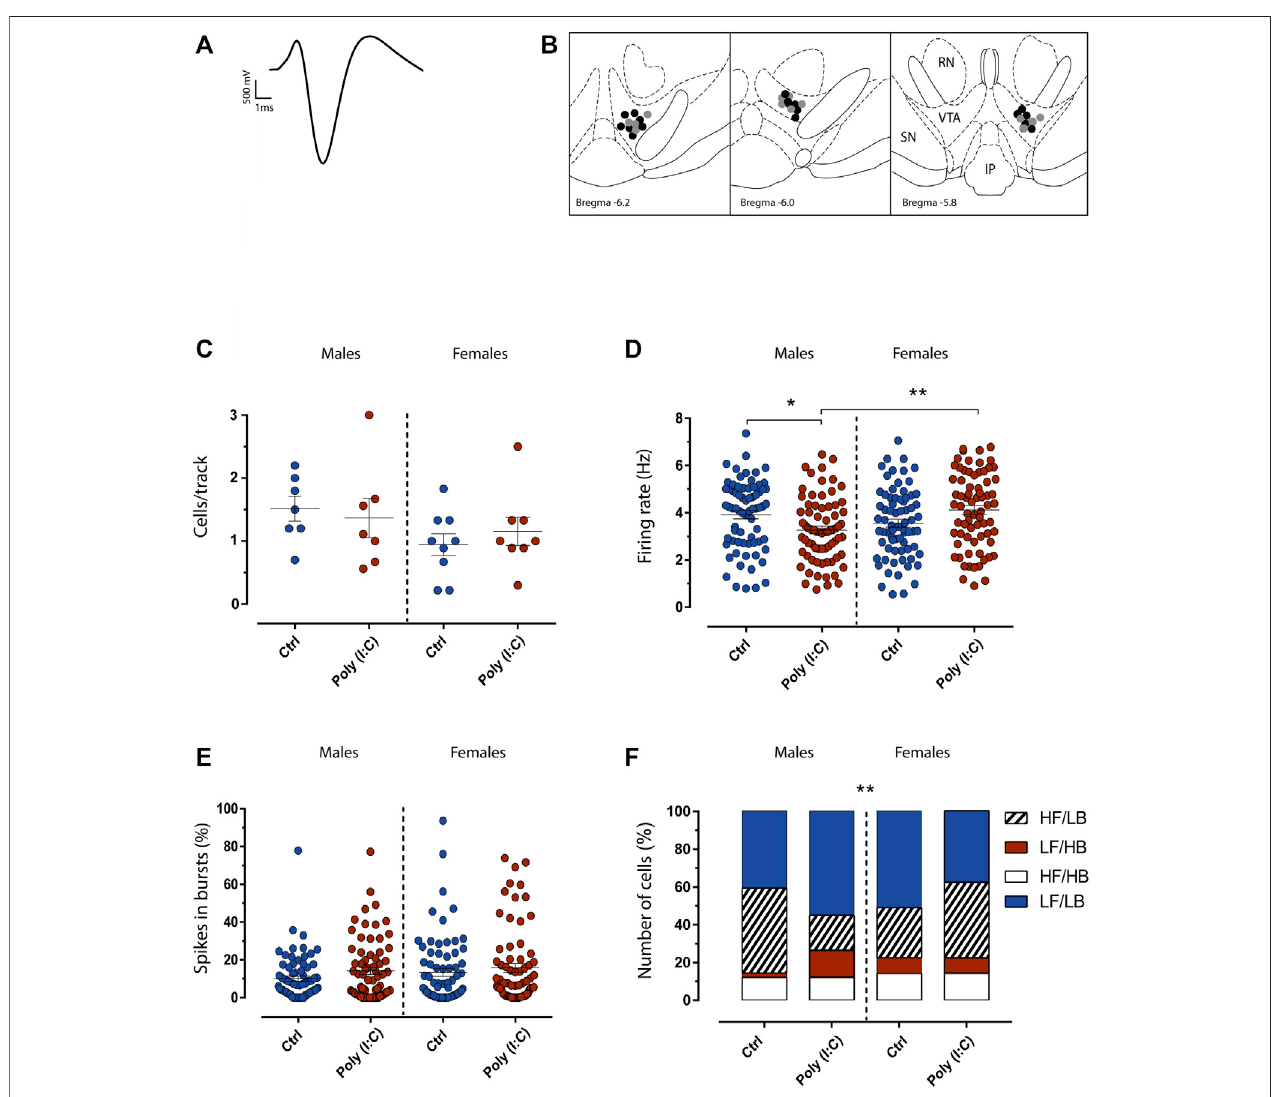
FIGURE2| Maternal immuneactivation transgenerationallydysregulates dopamineneuron fi ring activity inadult F2 rats. (A) The typical broad spike waveform ofa dopamine neuron. (B) Representative localization of recording sites of VTA putative dopamine neurons in Ctrl (grey dots) and poly (I:C) (black dots) offspring, as veri fi ed by histological sections. RN, red nucleus; IP, interpeduncularnucleus, SN, substantia nigra pars reticulata. (C) The Scatter plot shows the number of spontaneously active dopamine neurons. (D) Scatter plot shows individual dopamine neuron fi ring rate in Ctrl and Poly (I:C) rats. The scatter plot in (E) displays